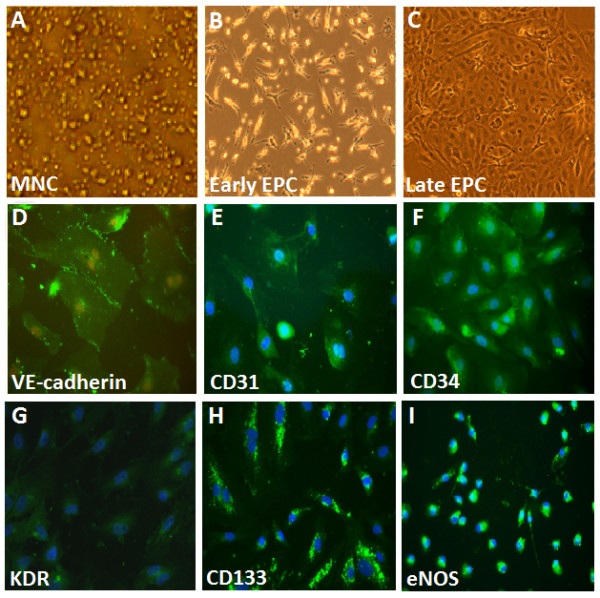
 Morphology and characterization of human endothelial progenitor cells (EPCs) from peripheral blood. (A) Peripheral blood mononuclear cells (MNCs) were plated on a fibronectin-coated culture dish on the first day. (B) Four days after plating, adherent early EPCs with a spindle shape were shown. (C) Three weeks after plating, ECFCs with a cobblestone-like morphology were selected, reseeded, and grown to confluence. (D-I) ECFC characterization was performed by immunohistochemical staining. Most of the EPC expressed endothelial and hematopoietic stem cell markers, VE-cadherin, PECAM-1 (CD31), CD34, KDR, AC133, and eNOS, which are considered critical markers of EPCs. Cells were counterstained with 4',6-diamidino-2-phenylindole (DAPI) for the nuclei (blue).